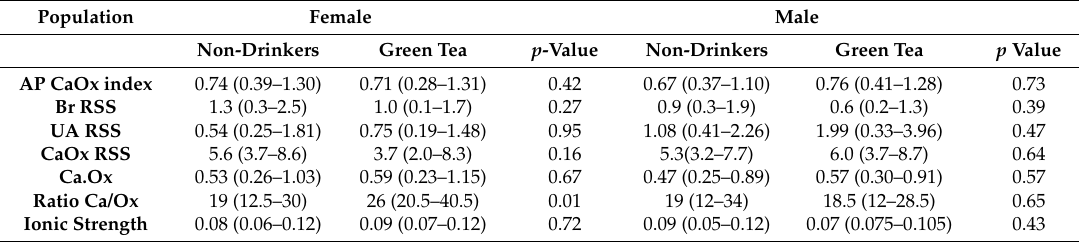
Table 3. Twenty-four hour urine supersaturation